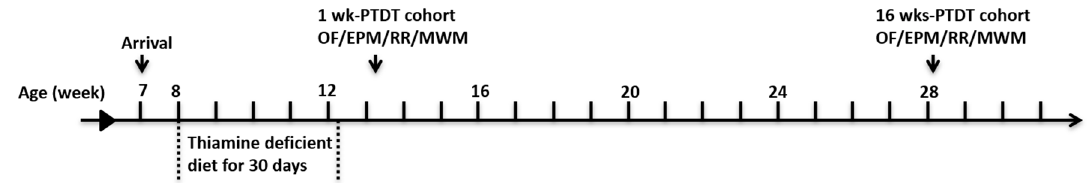
Figure 1. Schematic representation of the timeline of thiamine deficiency (TD) treatment and behavioral tests for the two cohorts of male C57BL6 mice. The behavioral tests were performed in the order of open field (OF), elevated plus maze (EPM), rotor rod (RR), and Morris water maze (MWM) either one week post TD treatment (1 wk-PTDT cohort) or 16 weeks post TD treatment (16 wks-PTDT cohort). For the 1 wk-PTDT cohort, n = 10 for both control and TD groups. For the 16 wks-PTDT cohort, n = 10 for control group, and n = 9 for TD group.